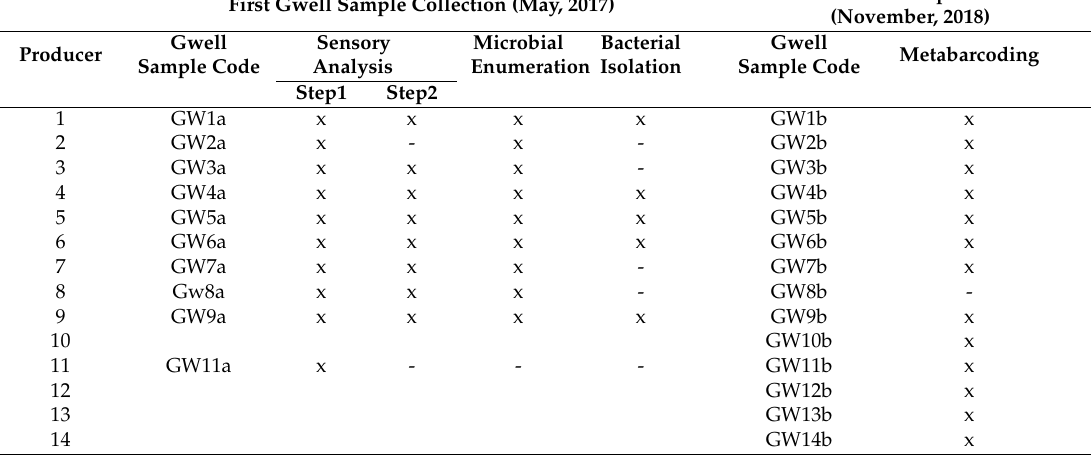
Table 1. List of the 23 Gwell samples studied in this study and respective analysis performed on it. Gwell samples share the same ID when coming from the same producers; a, corresponding to the samples analyzed in the first step of the study; b, corresponding to the samples analyzed during the second step of the study, 18 months